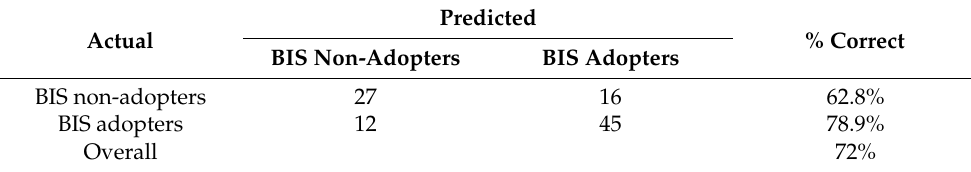
Table 5. Classification